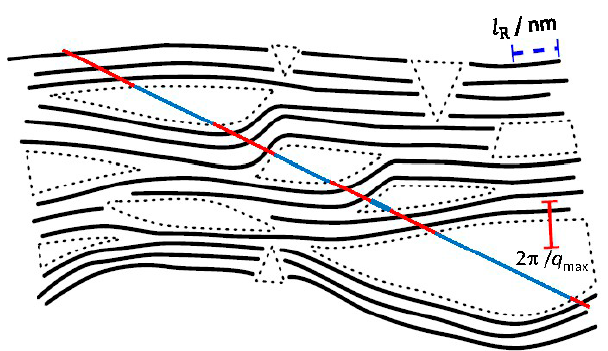
Figure 5. Nanostructure of CDCs described in terms of the chord length distribution [75]. The definition of a chord in partially ordered materials: Contributions to g ( r ) from chords that go through the pores (blue solid lines) and chords that go through the solid pore walls (red solid lines), as noted in Figure. This figure also serves for the visualization of the structure of the CDCs on the nanoscopic level. Reproduced with permission from [75] copyright © 2019, Elsevier.